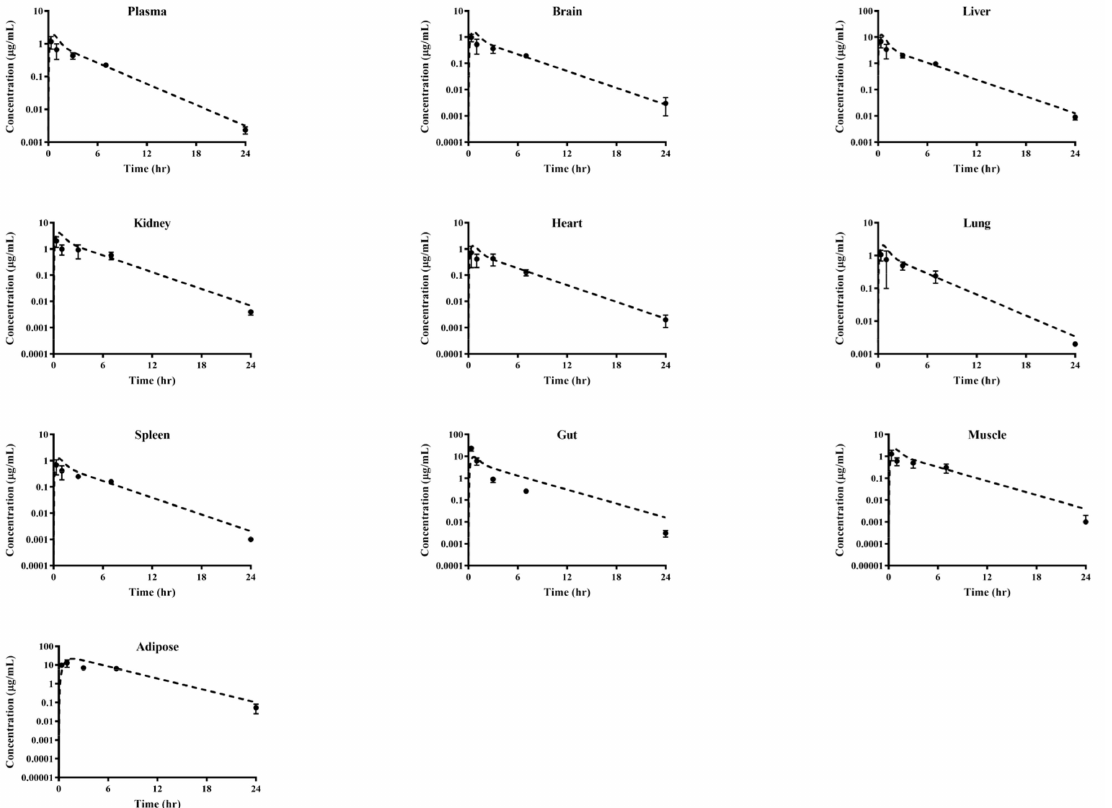
Figure 4. Observed and simulated plasma and tissue concentration–time profiles of supinoxin in different tissues after the oral administration of 5 mg/kg to rats. Closed squares and dotted lines represent the observed and simulated values, respectively ( n =